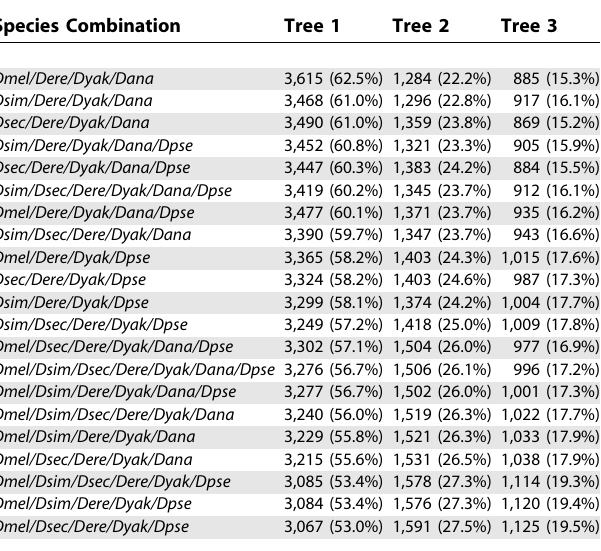
Table 2. Congruence across 21 Species Combinations Species Combination Tree 1 Tree 2 Tree